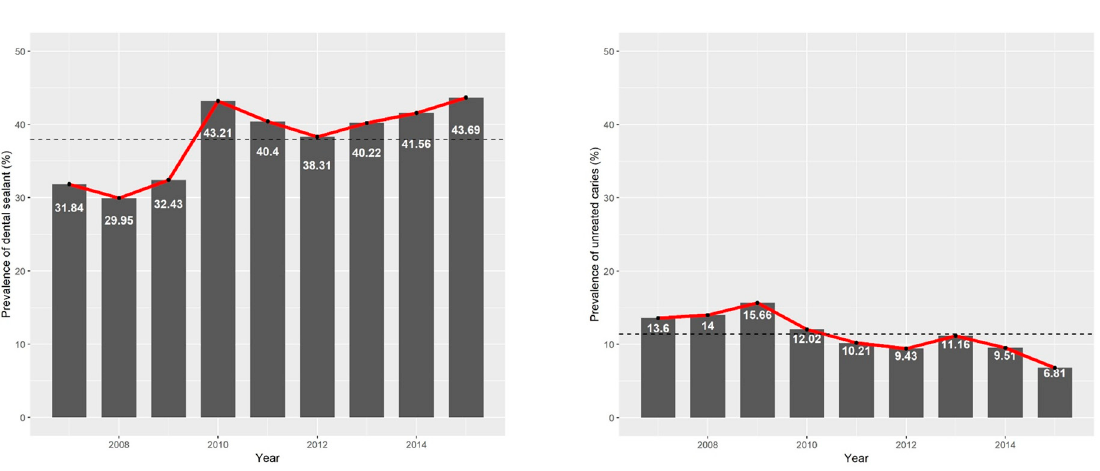
Figure 1. Changes in the prevalence of dental sealant use and untreated caries over time.